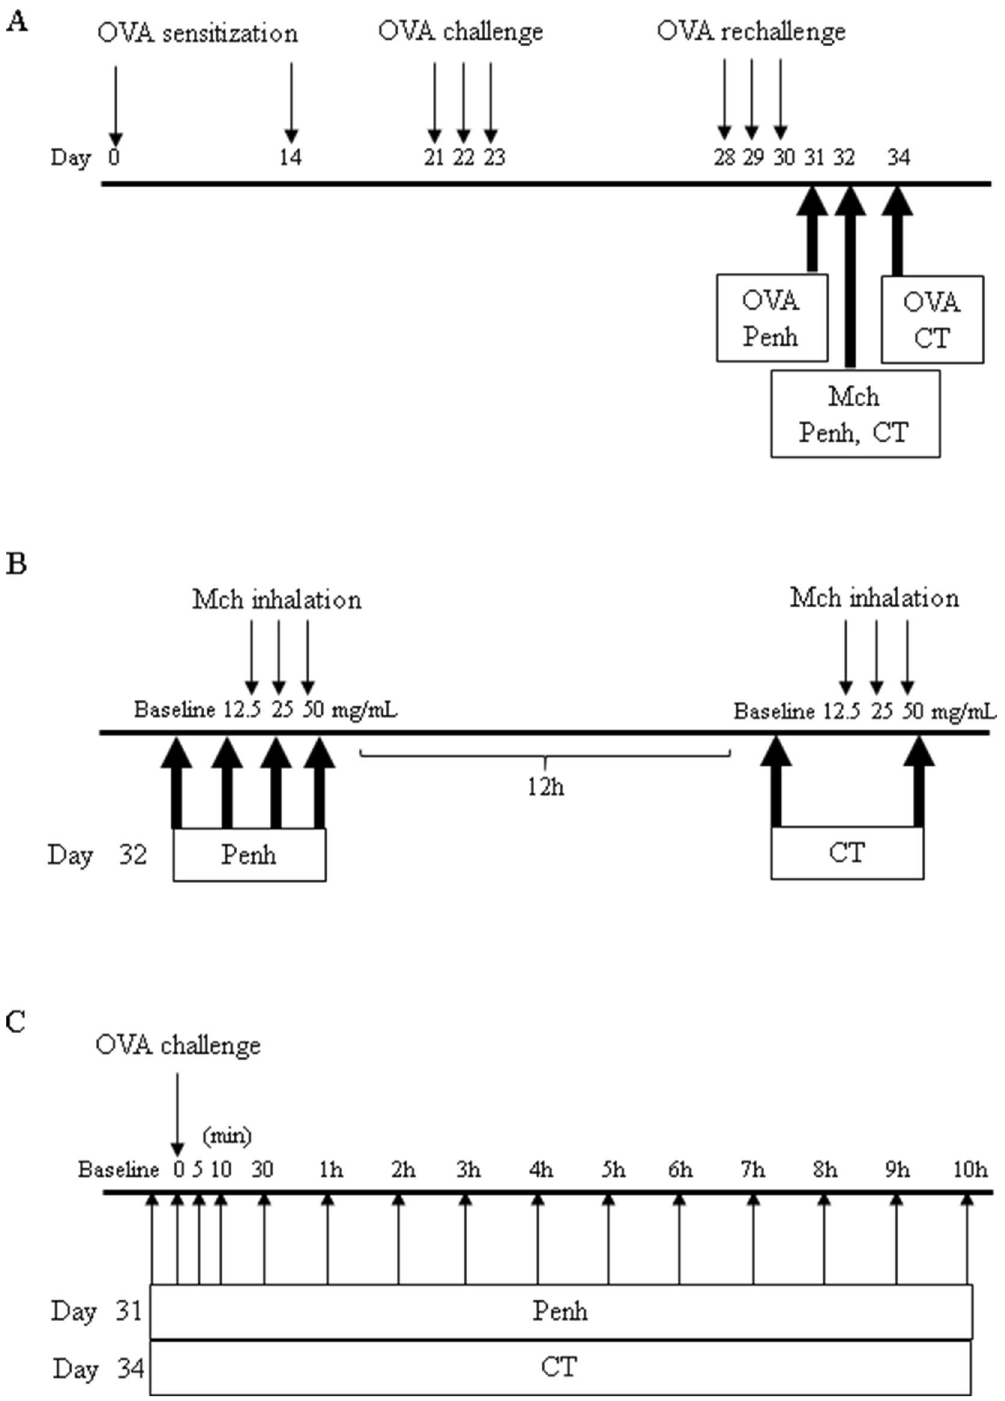
Figure 1. Mouse model of ovalbumin-induced asthma and study protocol. (A) Establishment of ovalbumin- induced asthma murine model, (B) noninvasive whole body plethysmography and UHRCT after methacholine challenge, (C) serial noninvasive whole body plethysmography and UHRCT after OVA challenge for 10 h in asthma